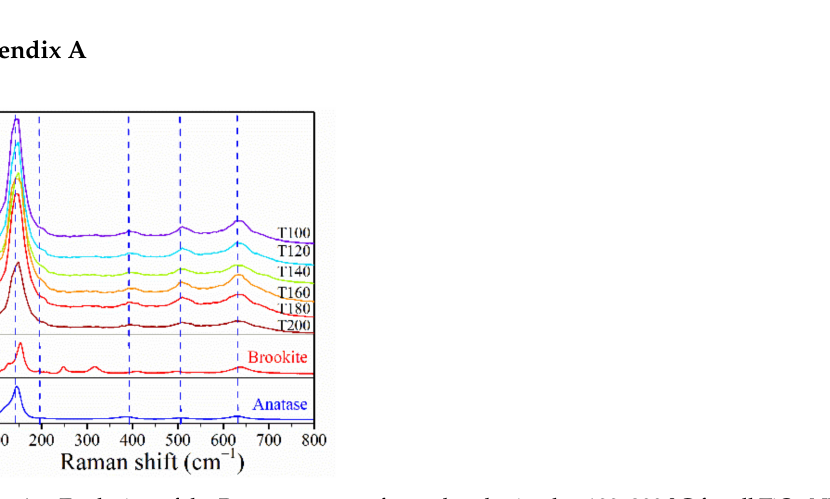
Figure A1. Evolution of the Raman spectra of samples obtained at 100–200 ◦ C for all TiO 2 NP samples.